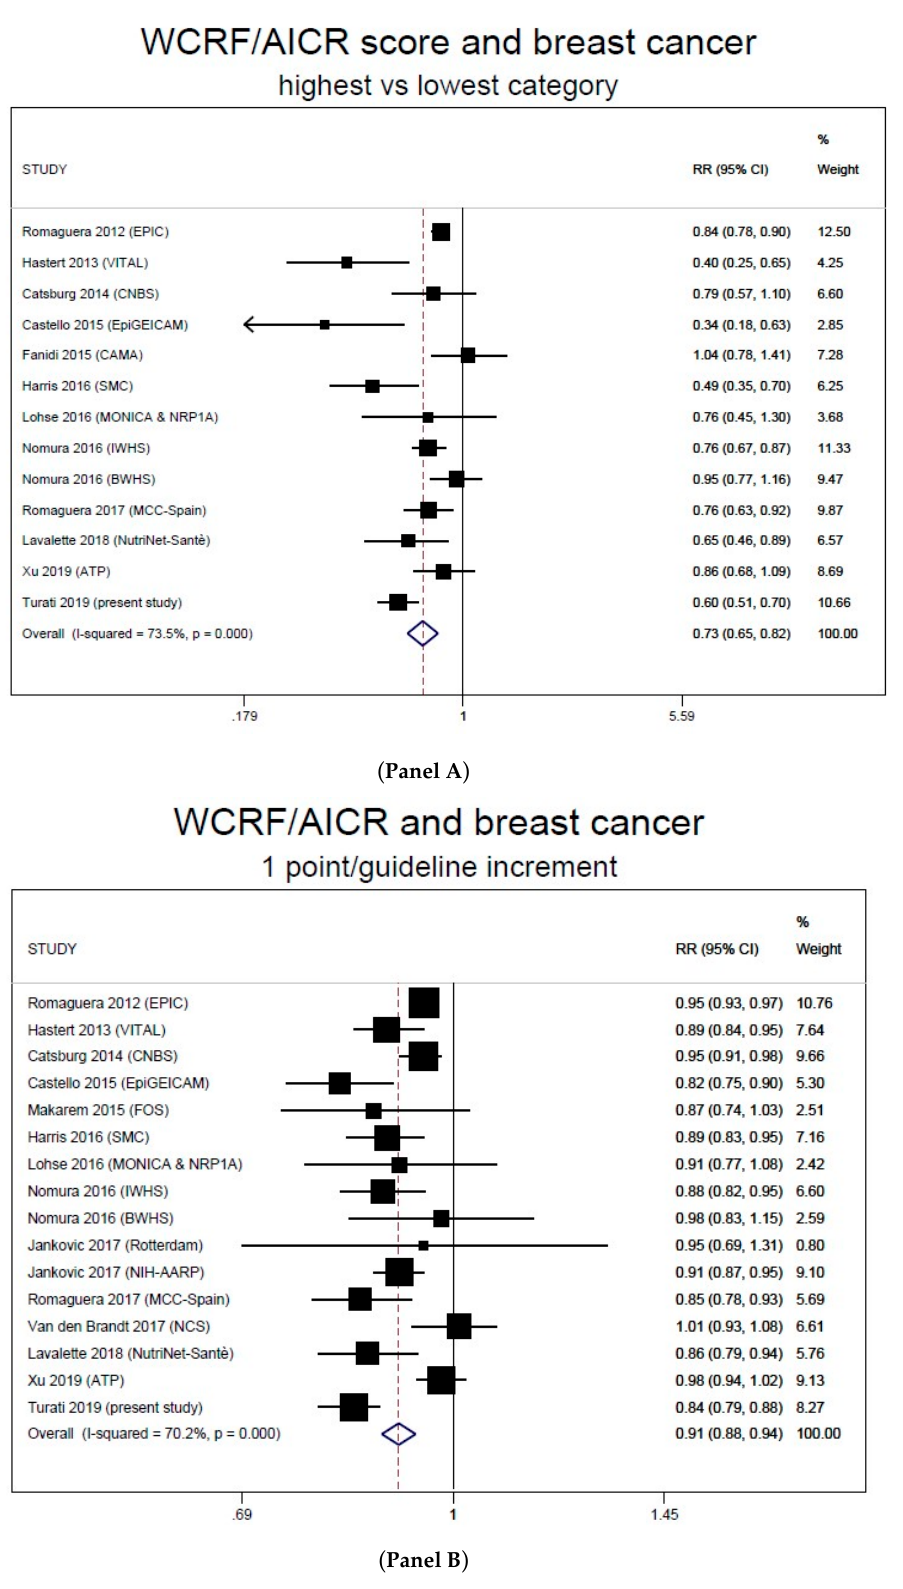
Figure 1. Forest plots for the extreme-quantile ( Panel A ) and linear dose-response ( Panel B ) meta-analyses on breast cancer and the WCRF/AICR score. WCRF/AICR, World Cancer Research Fund/American Institute for Cancer Research.